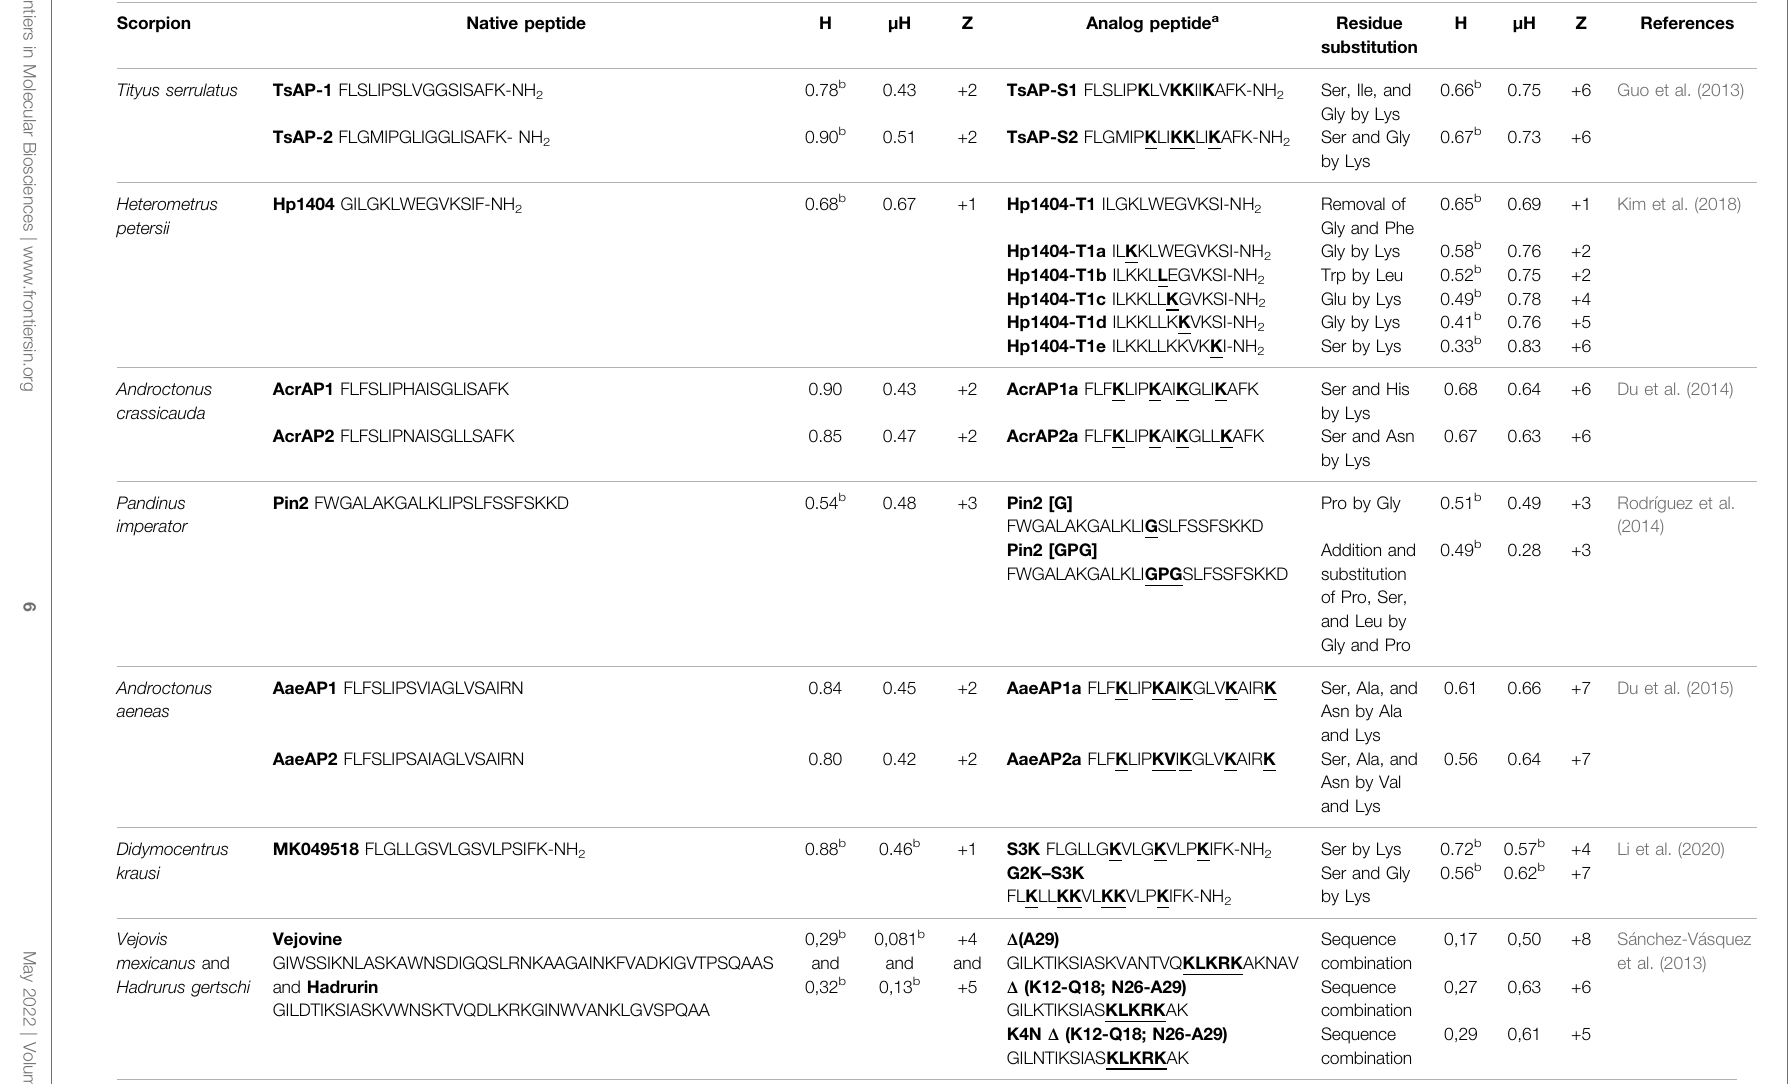
TABLE 1 | ( Continued ) Physicochemical characteristics of native antimicrobial peptides and scorpion